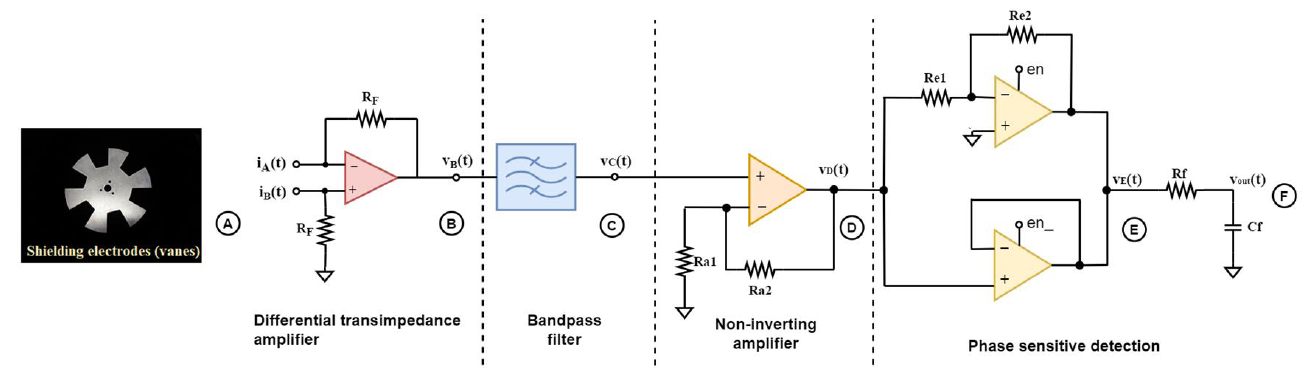
Figure 18. Final sensor interface design.